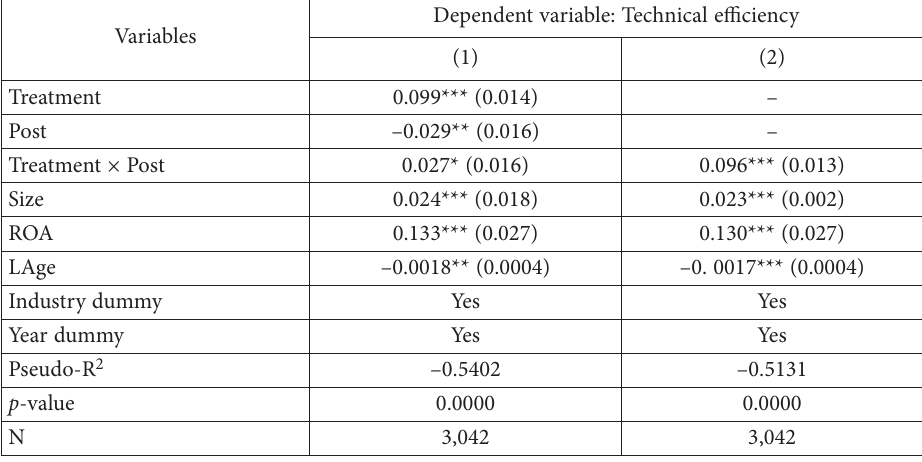
Table 5. The impact of mandatory CSR disclosure on firm technical efficiency (source: author’s calcula- tion)